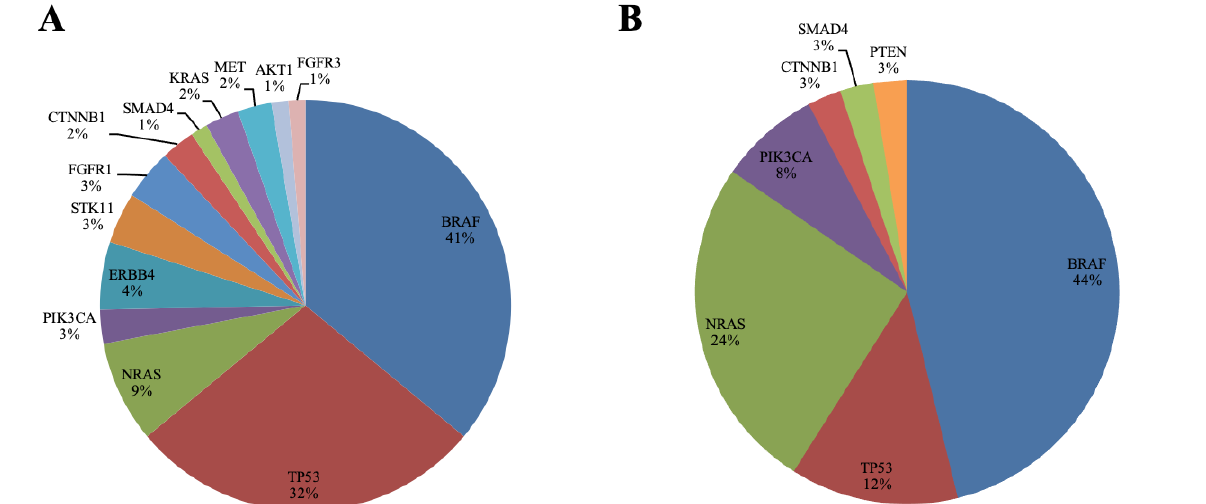
Figure 3. Pie charts representing the frequencies (%) of the examined genes identified segregated by gender; men (A) and women (B) from 107 patients included in the cohort. Frequencies are expressed as the percentage of positive samples for each molecular alteration relative to the total number of patients with an informative molecular